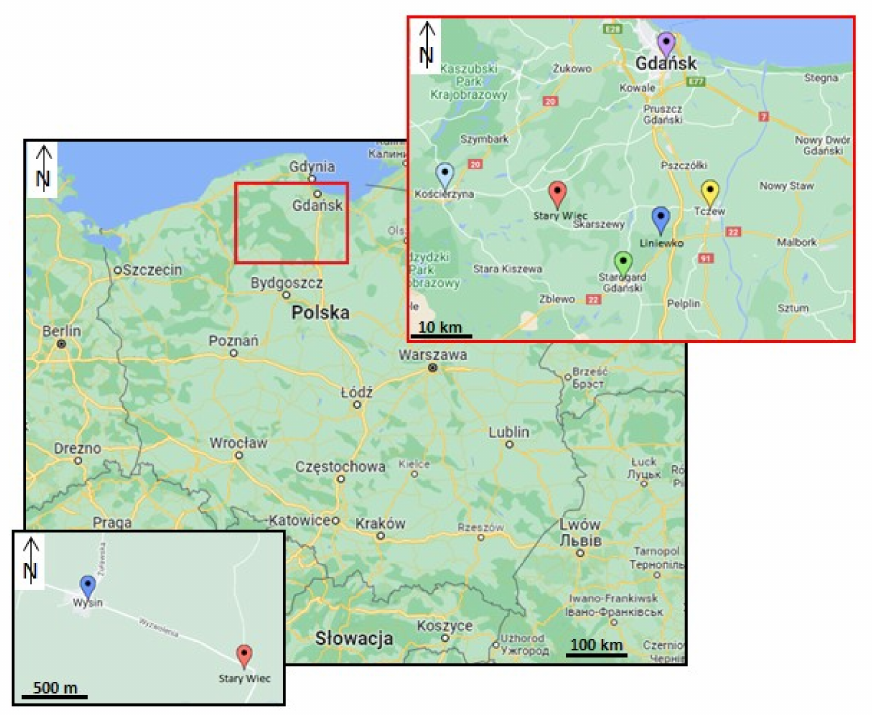
Figure 1. Map of Poland with marked Pomeranian region (red square) and locations of the air quality monitoring network sites and Stary Wiec station. (Available online: https://maps.google.com (accessed on 19 July